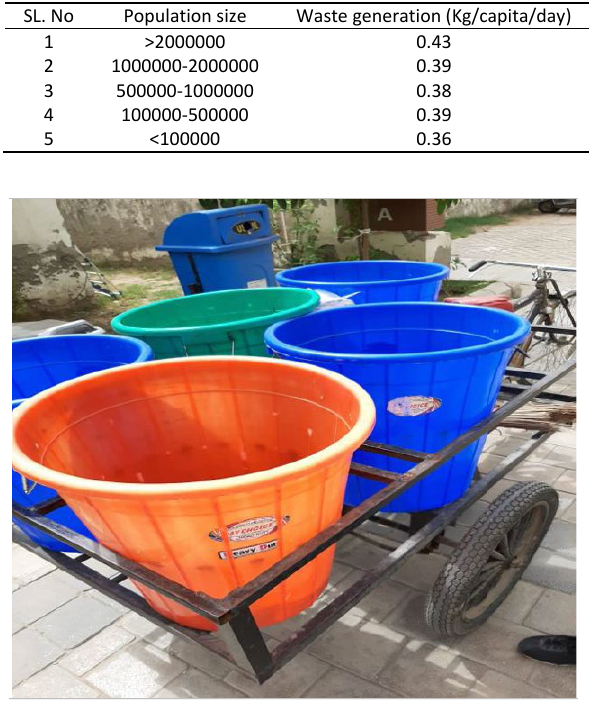
Fig. 2: Collection from house hold